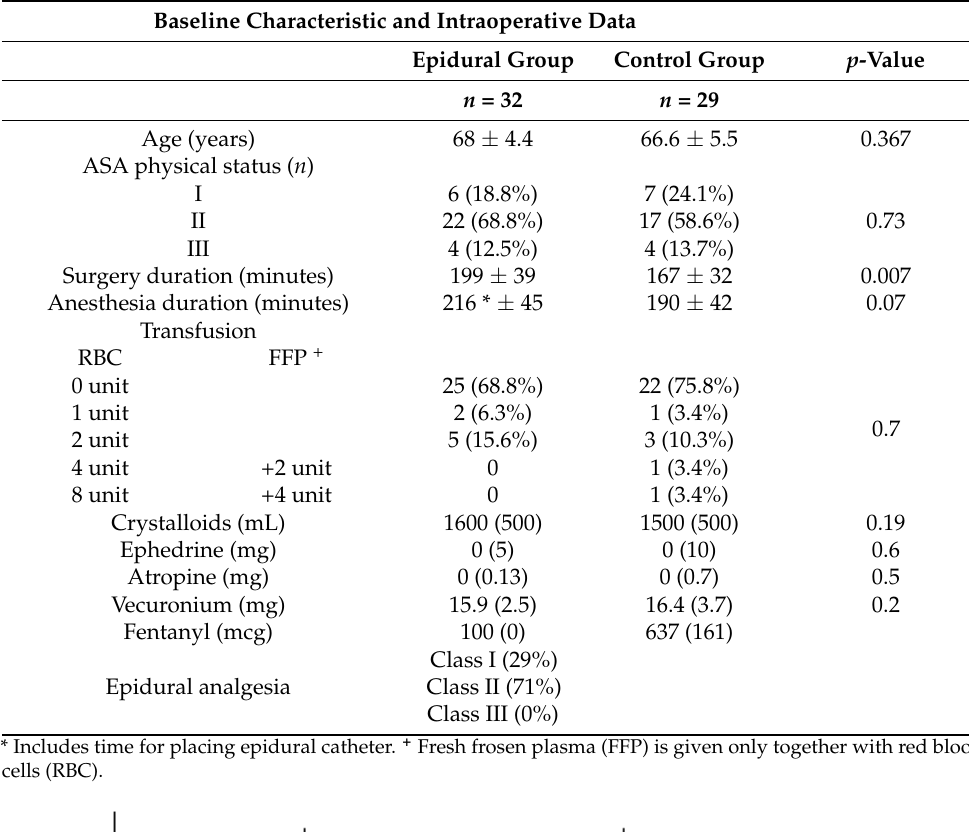
Table 1. Baseline data between the groups. Data are presented as mean ± SD, n (%) or median (interquartile range). Data were analysed using independent t test, Mann–Whitney U test, or Fisher’s exact test.